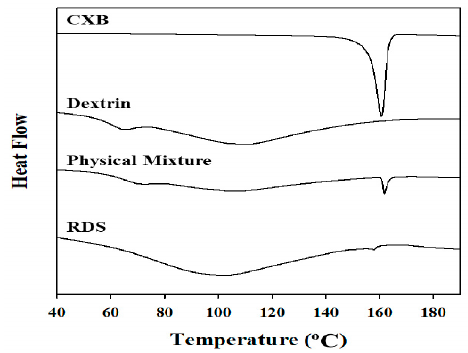
Figure 3. Differential scanning calorimetry (DSC) thermograms of CXB powder, dextrin, physical mixture, and RDS.